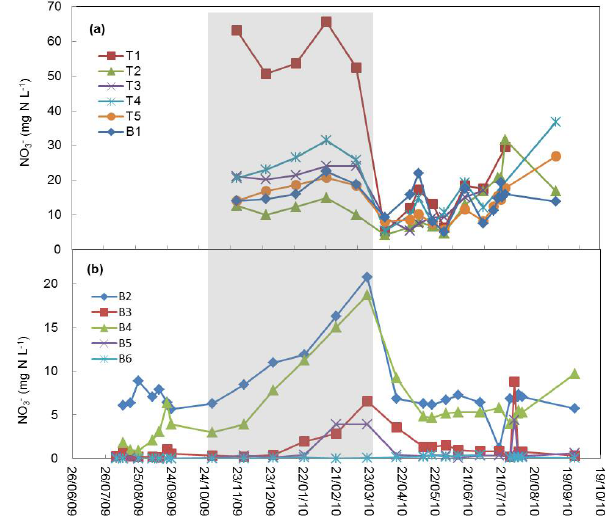
Fig. 7. (a) NO − concentration (mgNL − 1 ) in soil pore water at 3 5-cm depth at each plot of HS and (b) of groundwater at 30-cm depth in GDZ. NO − values from some of the HS plots during sum- 3 mer 2009 are missing because samplers were damaged by worms. Shaded area indicates the dry-cool